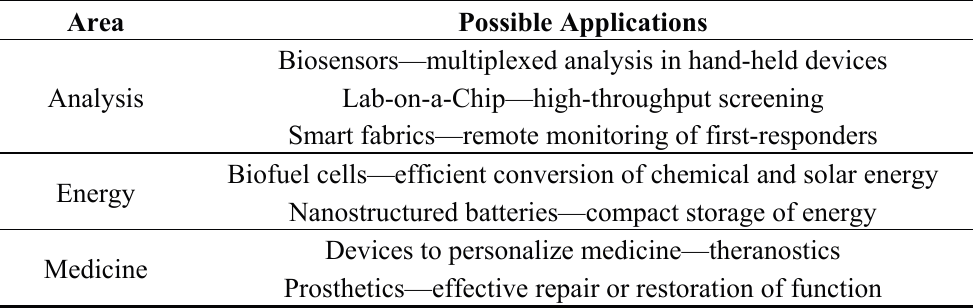
Table 1. Examples of opportunities enabled by bio-device integration.